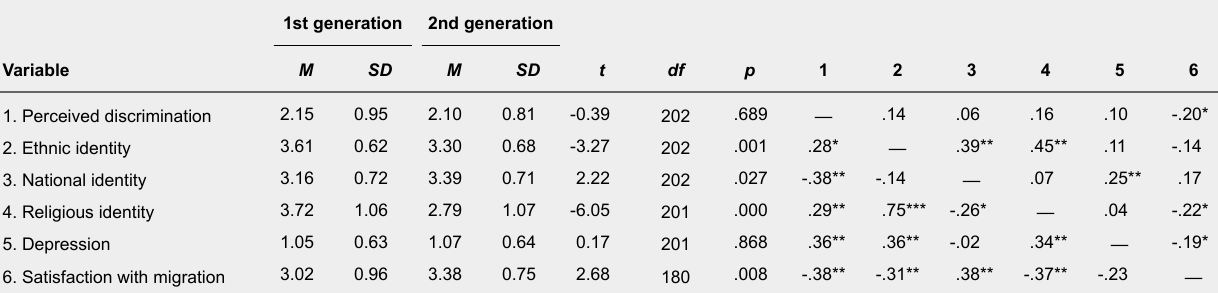
Note. Correlations for first generation Muslims are above diagonal, correlations for second generation Muslims are below